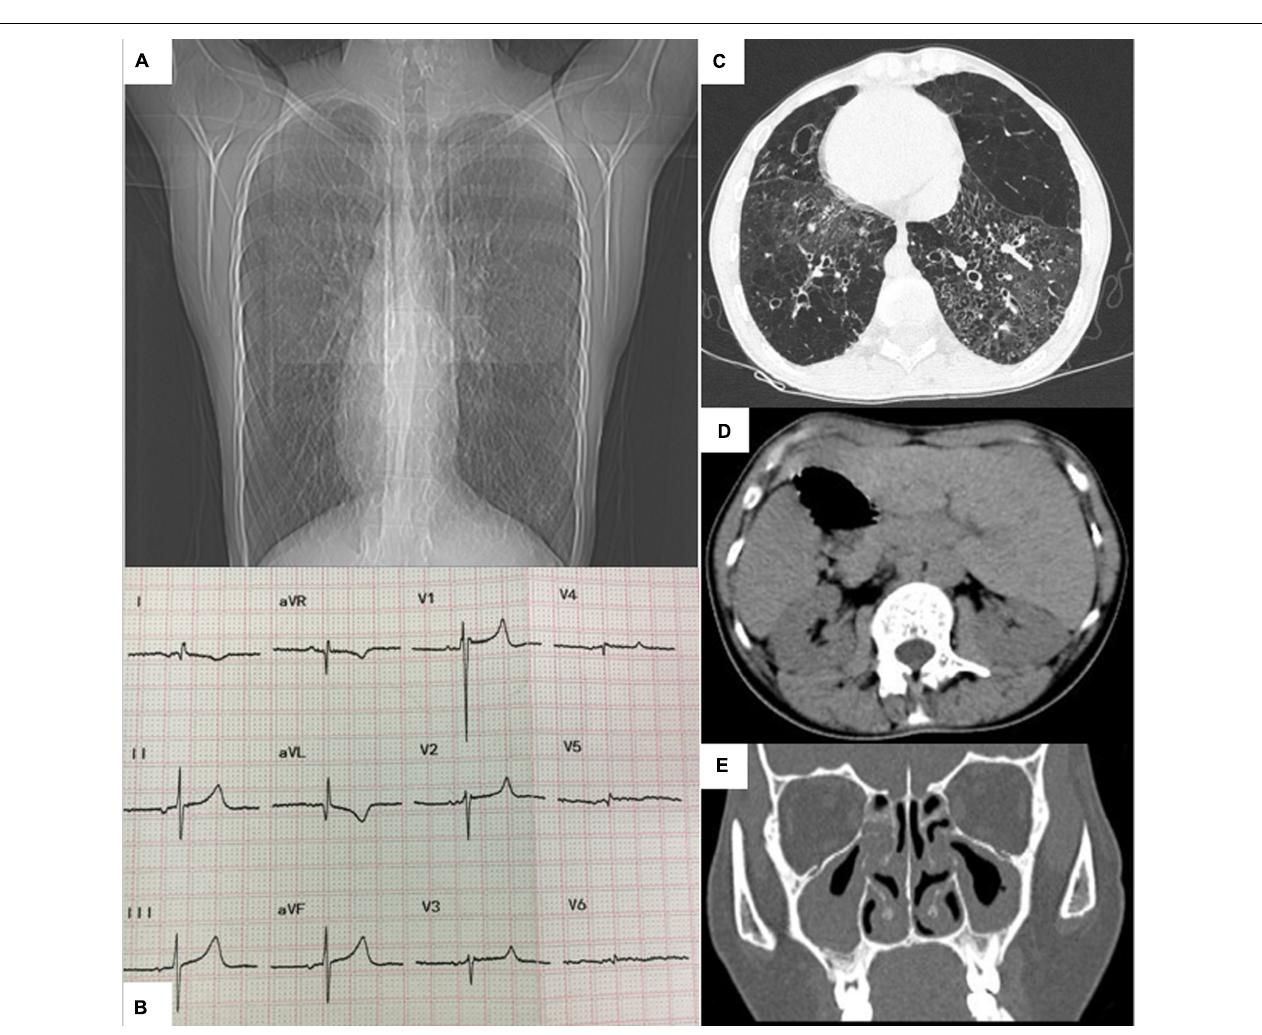
FIGURE 1 | (A) Chest radiograph showing dextrocardia. (B) Electrocardiogram showing dextrocardia with tall R waves in lead V1 and absent R in V6. (C) Chest CT showing bronchiectasis. (D) Abdomen CT image showing liver on the left, stomach and spleen on the right. (E) CT of sinuses showing mucosal thickening.